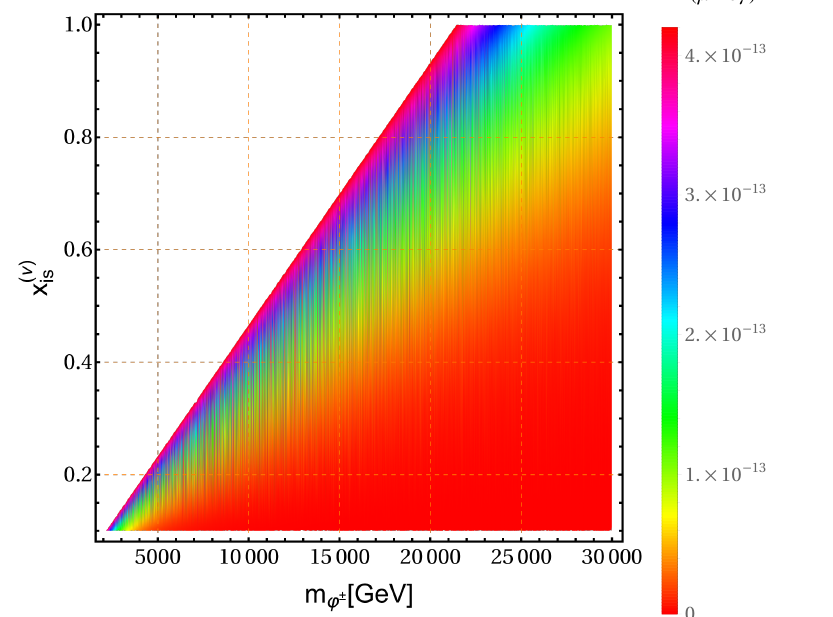
Figure 3 . Allowed parameter space in the m flavor-violating constraints.